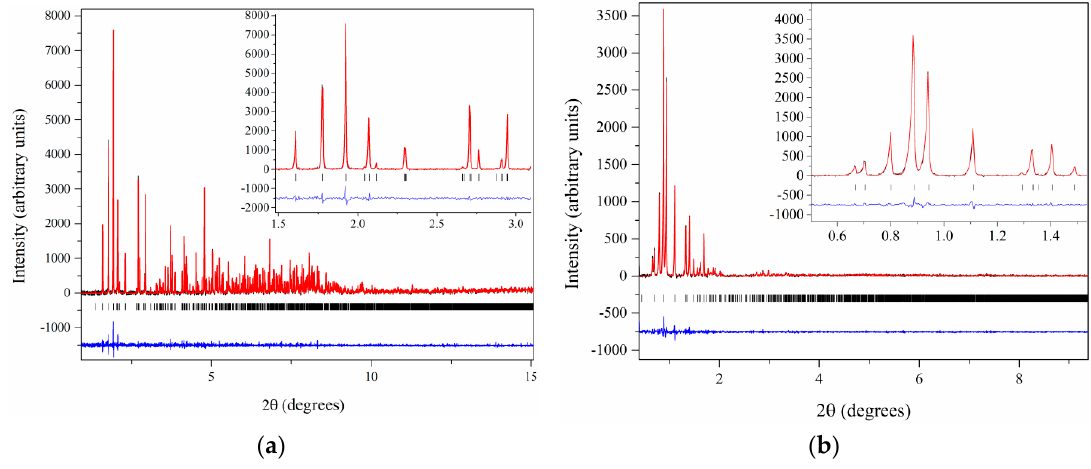
Figure 10. Pawley fit of two diffraction patterns of HI cocrystallized with 4-ethylresorcinol collected on ID31 (now ID22) at ESRF ( λ = 1.29994(1) Å, RT) corresponding to: ( a ) Polymorph P 2 1( γ ) crystallized at pH 5.02. ( b ) Polymorph P 2 1( α ) crystallized at pH 5.80 . The black, red and lower blue lines represent the experimental data, the calculated pattern and the difference between the experimental and calculated profiles, respectively. The vertical bars correspond to Bragg reflections compatible with space group P 2 1 (Reproduction of Figures 5 and 8 from reference